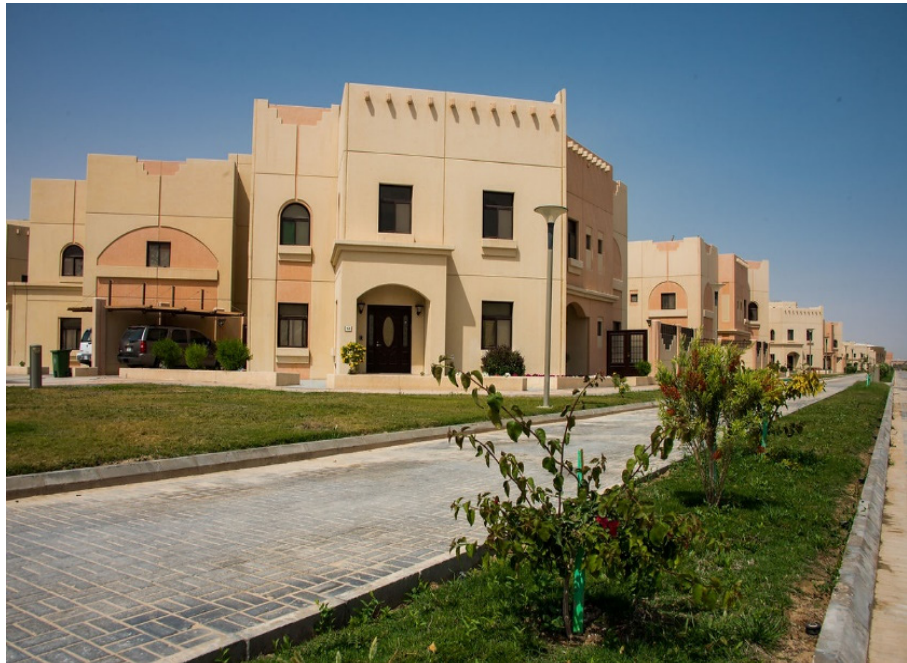
Figure 4. Case study residential area